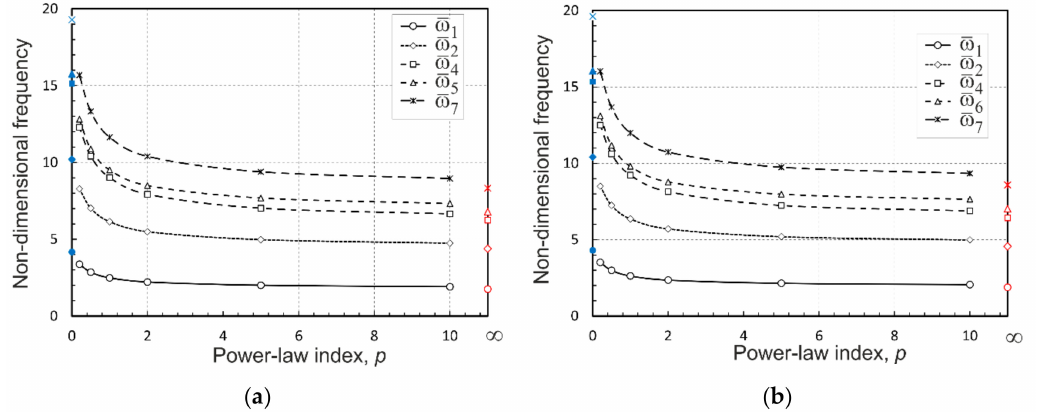
Figure 6. The e ff ect of the material gradation profile on natural frequencies of: ( a ) SSSS plates and ( b ) CCCC